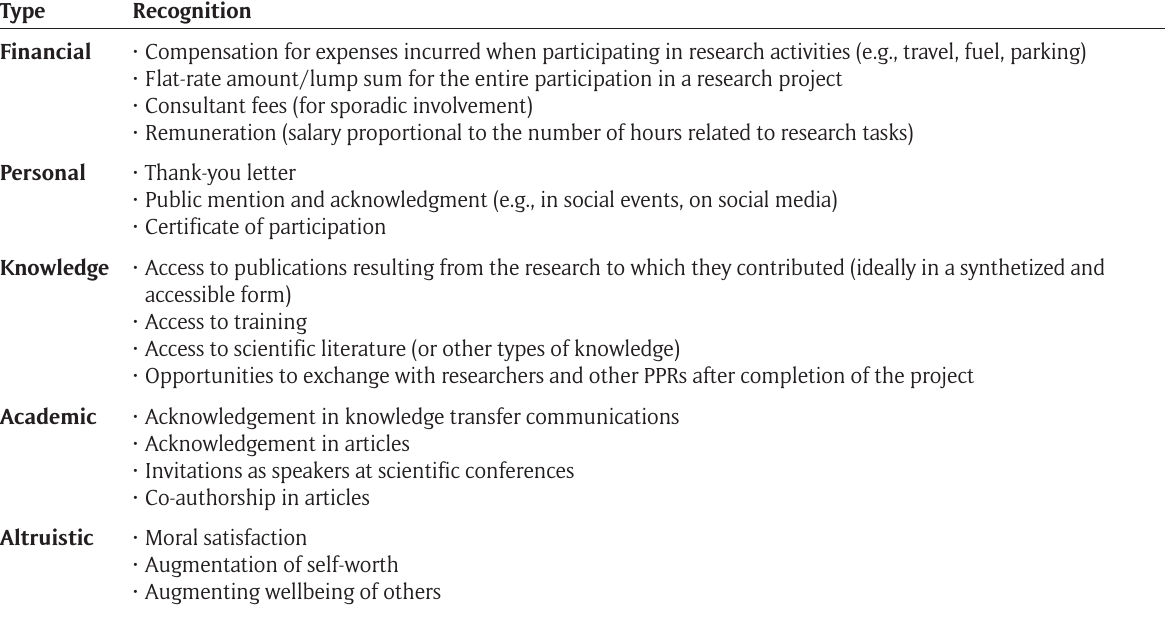
Table 2: Diversity of PPRs Recognitions in